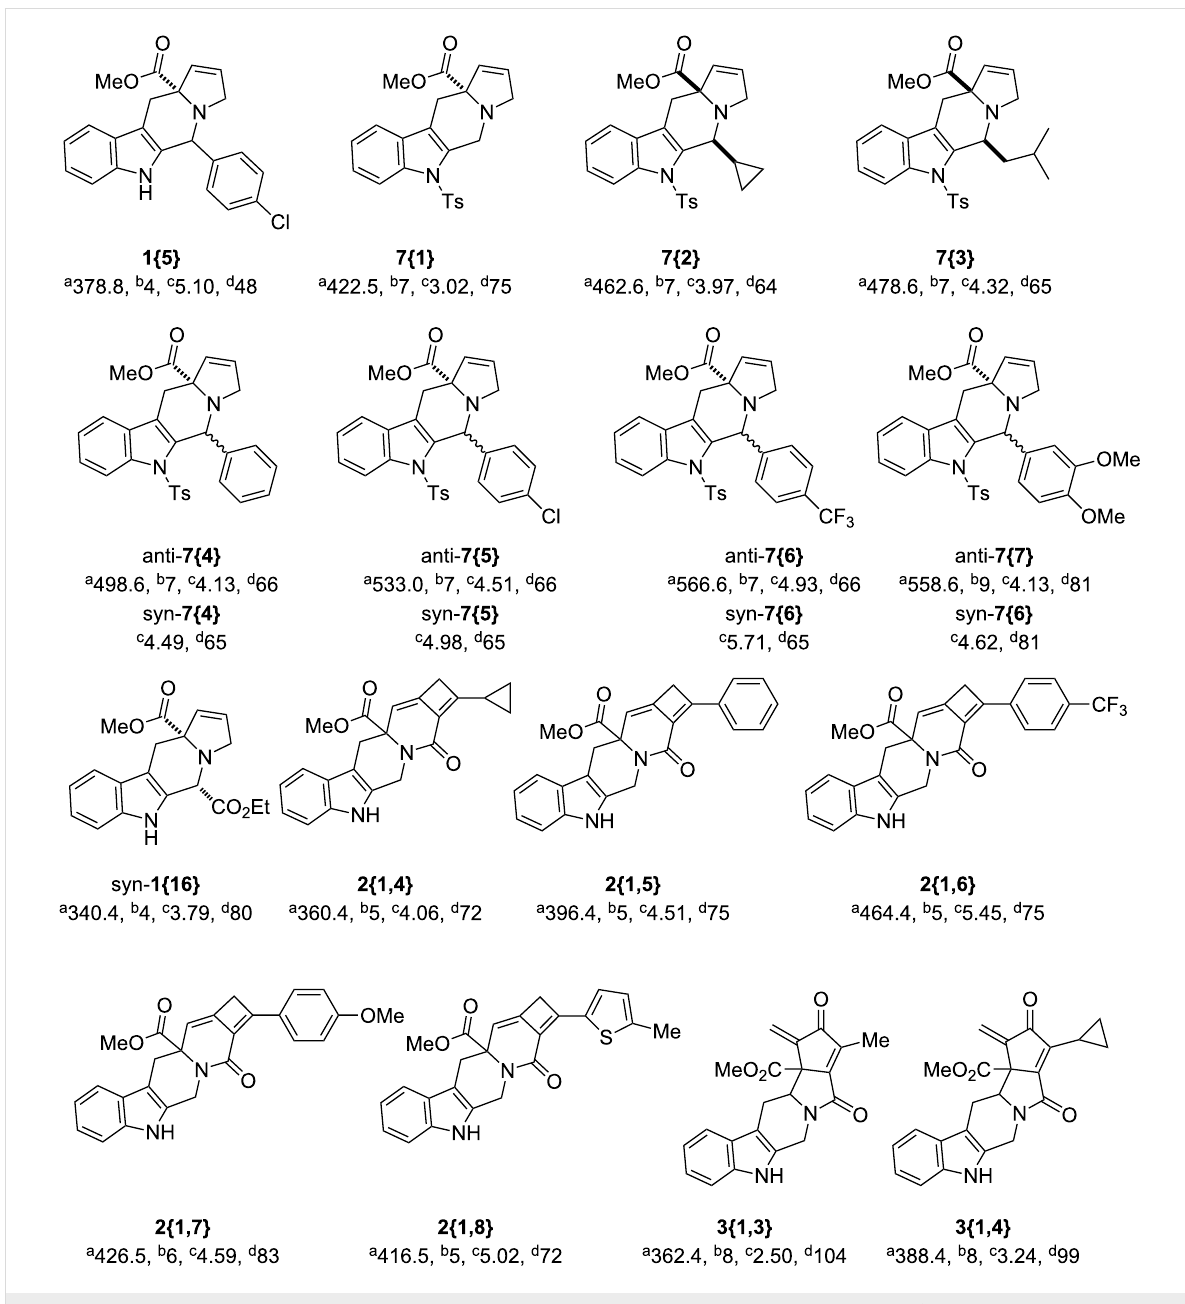
Figure 2: Library of tetrahydro- β -carboline containing compounds 1 – 7 and calculated properties ( a molecular weight; b hydrogen-bond donor/accep- tors; c cLogP; d polar surface area